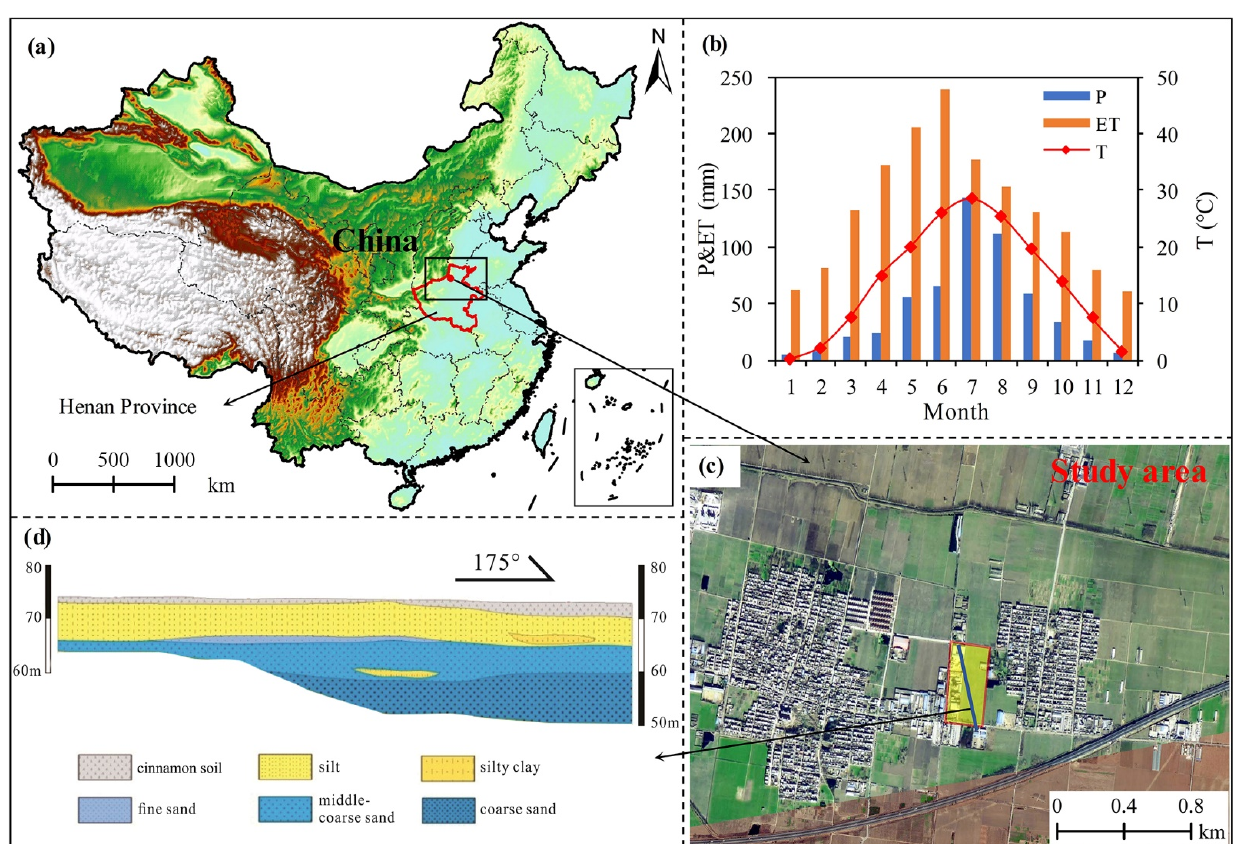
Figure 1. ( a ) Location of the study area. ( b ) Annual precipitation, evaporation and temperature in the study area (P: precipitation; ET: evaporation; T: temperature). ( c ) Enlarged map of the study area. ( d ) Geological conditions in the study